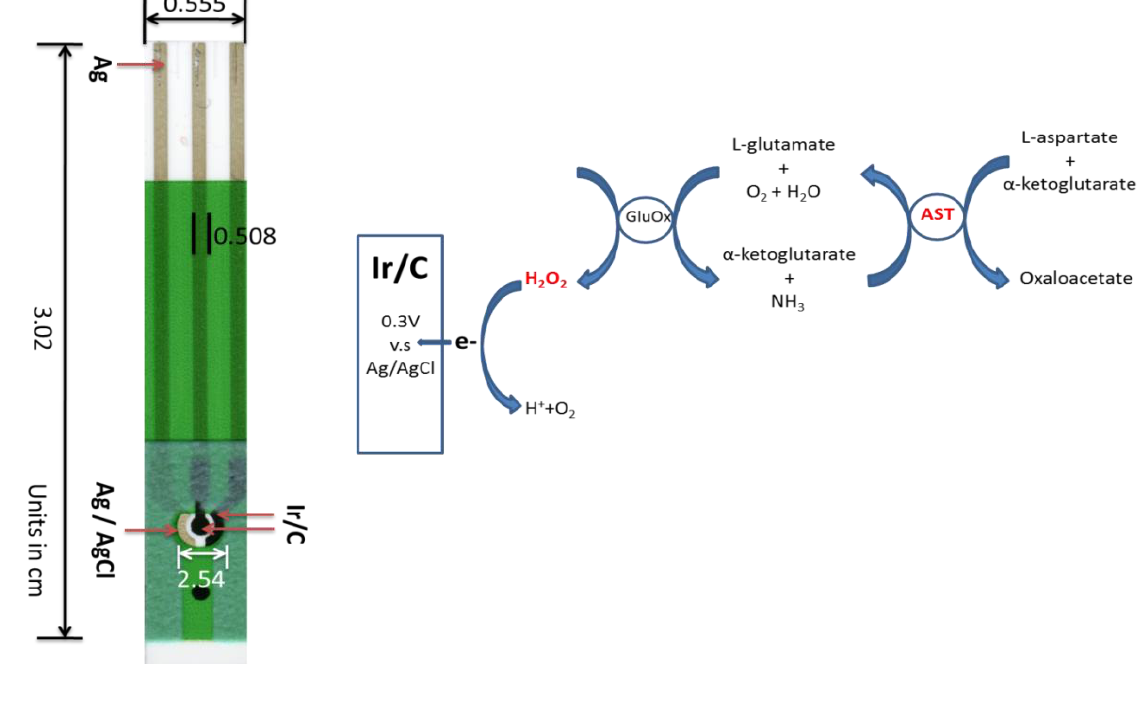
Figure 1. Sensor prototype and reaction mechanism used for the AST